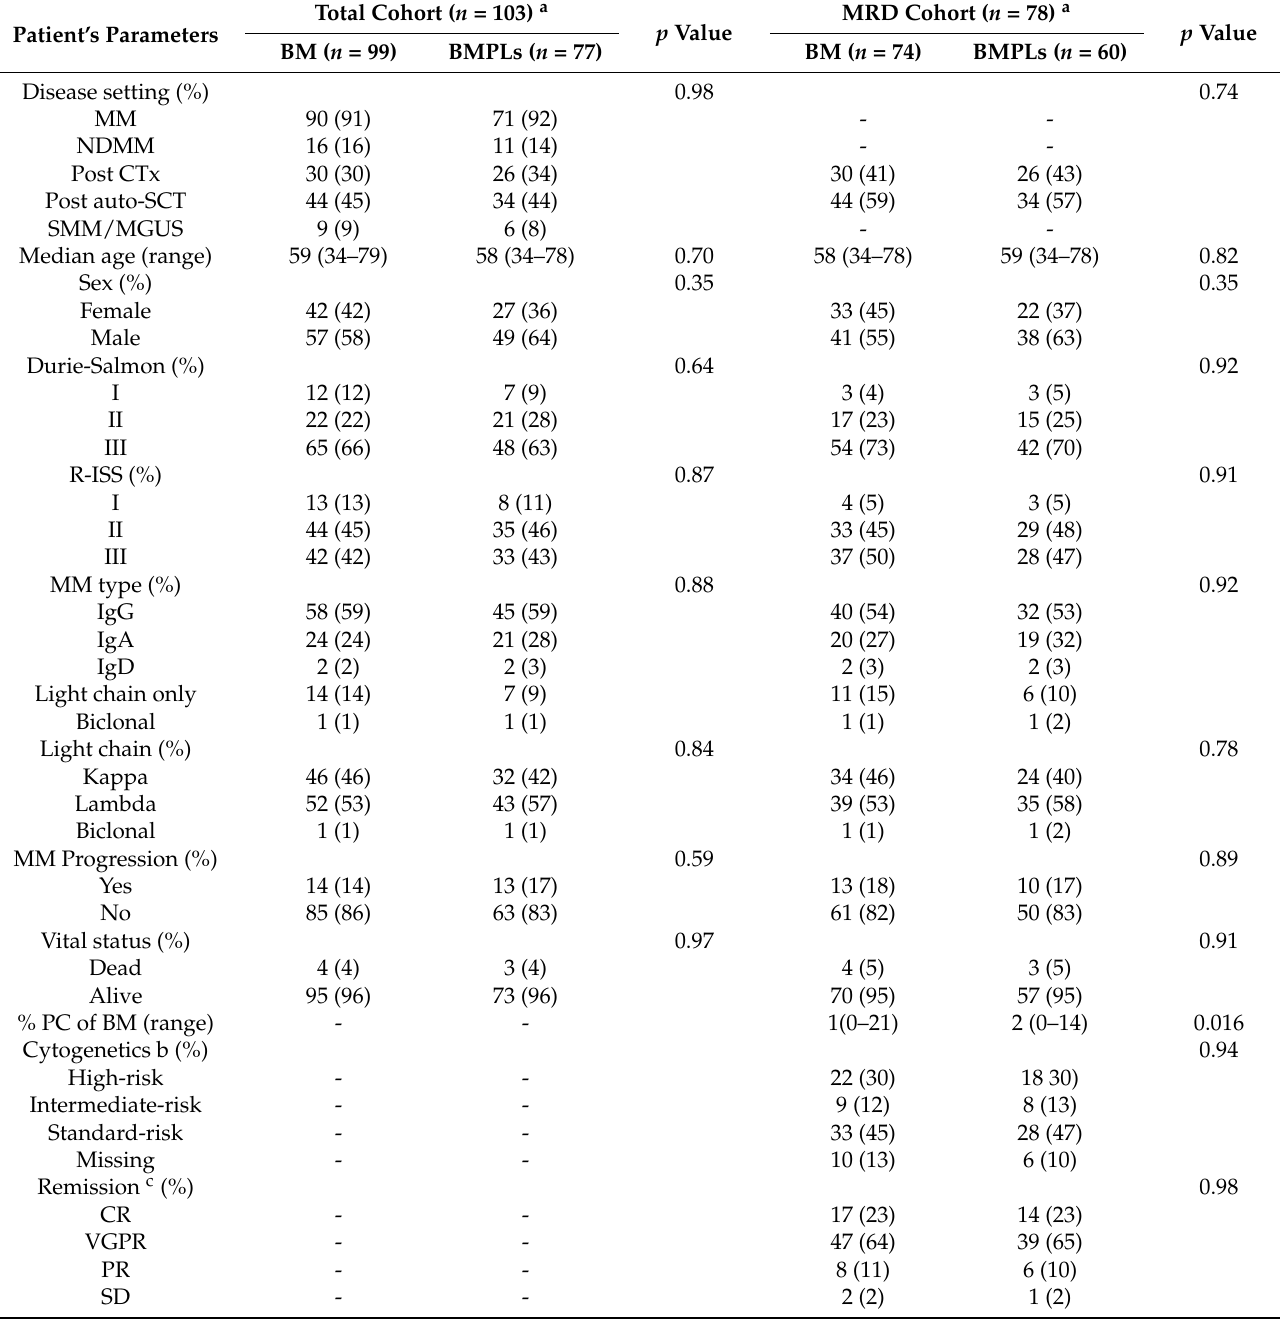
Table 1. Characteristics of the patients in BM or BMPLs group of total cohort or MRD